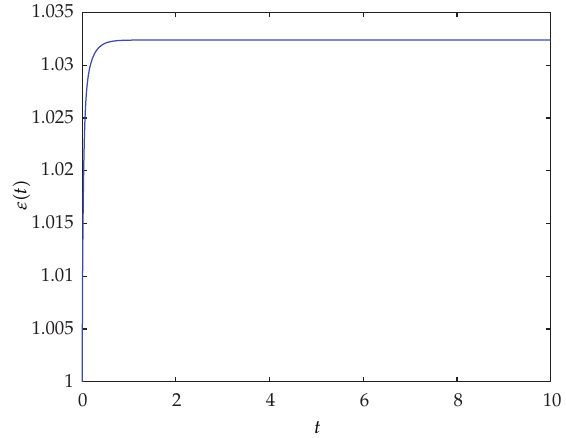
Figure 4: Time evolution of control strength ε (cid:4) t (cid:5)